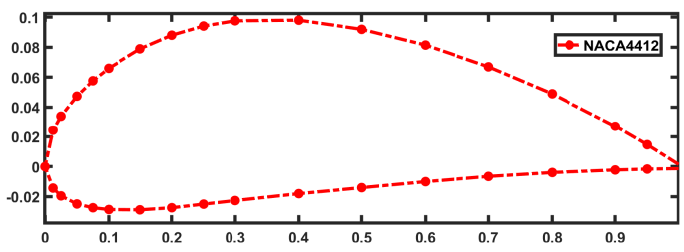
Figure 1. NACA 4412 Airfoil shape.